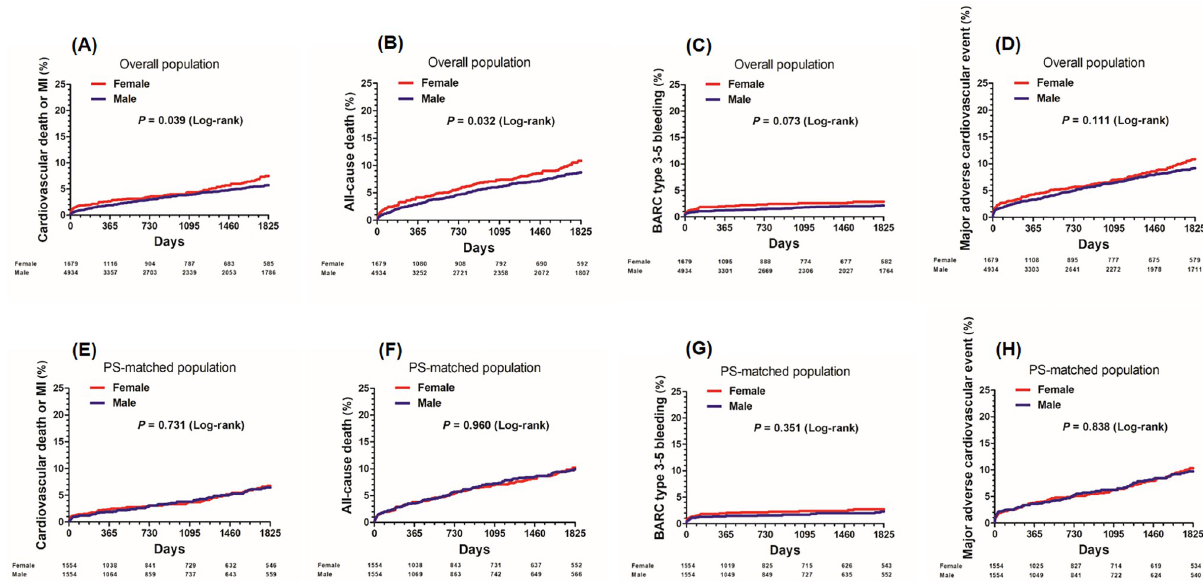
Fig 2. Kaplan-Meier curves comparing 5-year risk of clinical outcomes according to sex. CABG = coronary artery bypass grafting, BARC = bleeding academic research consortium, MI = myocardial infarction, PS = propensity score.